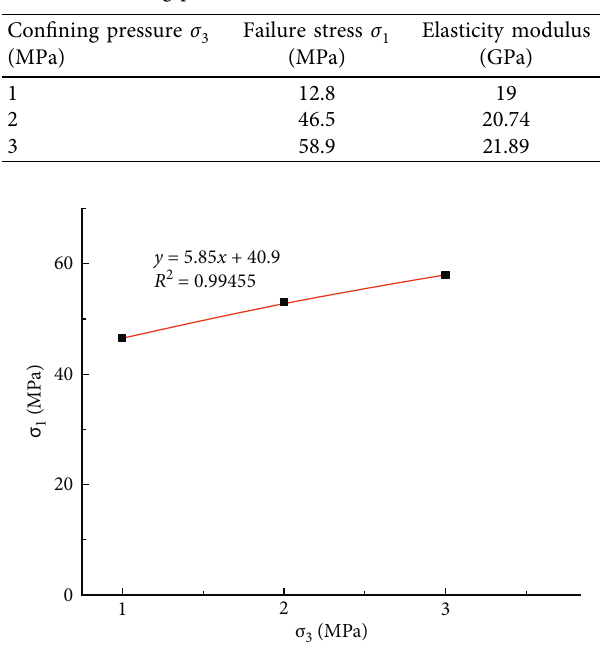
Figure 15: Linear regression of the relationship between ultimate strength of specimen and confining pressure.